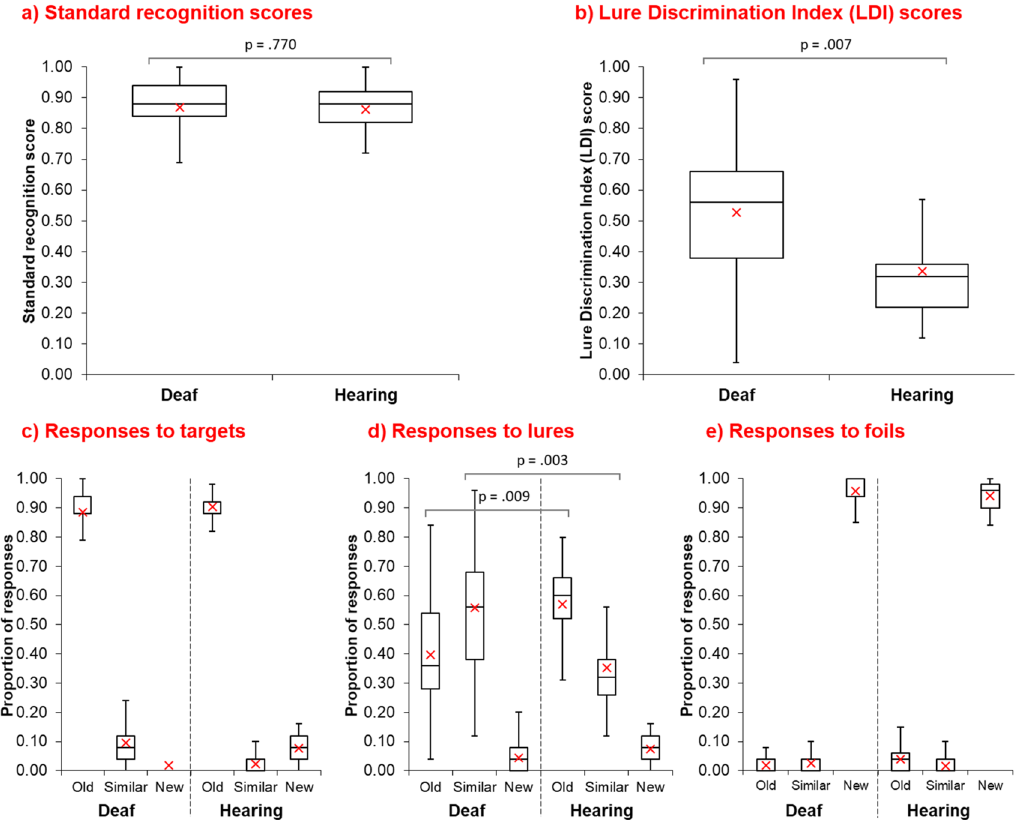
Figure 1. Long-term memory test performance. Box-whisker plots showing ( a ) standard recognition scores for the deaf group (N = 19) and hearing group (N = 19), ( b ) Lure Discrimination Index (LDI) scores for the deaf group and hearing group, and ( c – e ) the proportion of ‘old’, ‘similar’, and ‘new’ responses to targets ( c ), lures ( d ), and foils ( e ) for the deaf and hearing groups. The solid centre line in each box shows the median score for that group. The upper and lower boundaries of boxes represent the interquartile ranges. Box whiskers show the upper and lower quartiles of scores. The red asterisk in each box shows the mean.